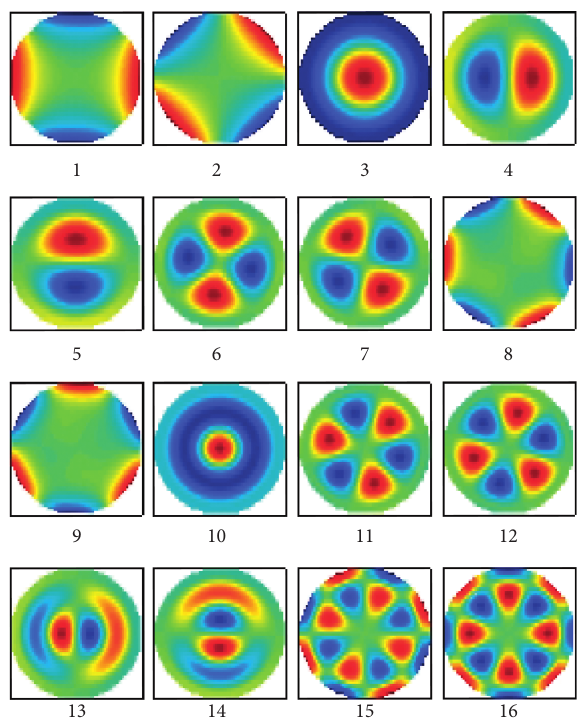
Figure 15: Contour plots of the mode shapes from the FE model of the